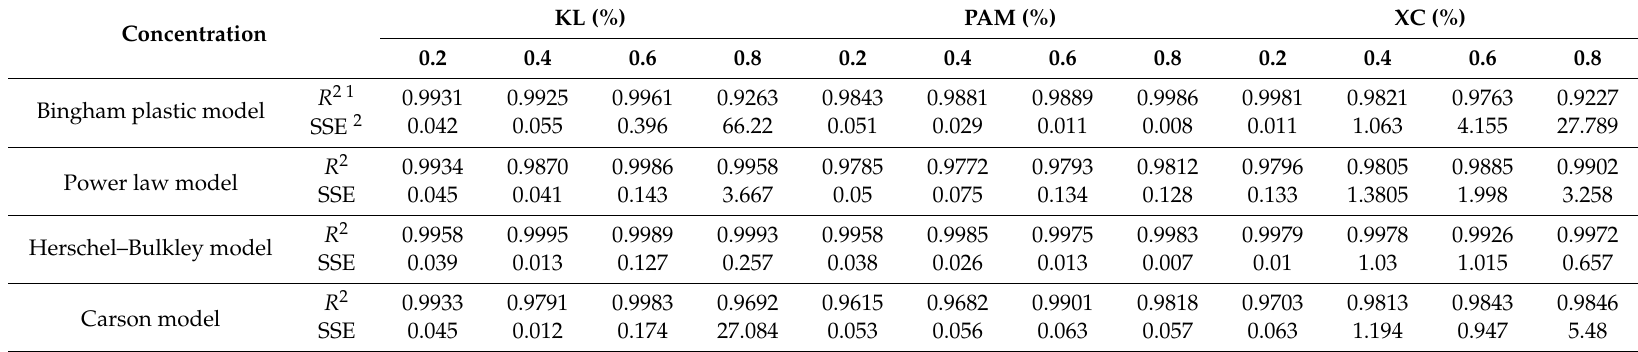
Table 2. Regression analysis of the degree of fitting R 2 and sum of square errors (SSE) for different concentrations of the three kinds of polymer drilling fluid.